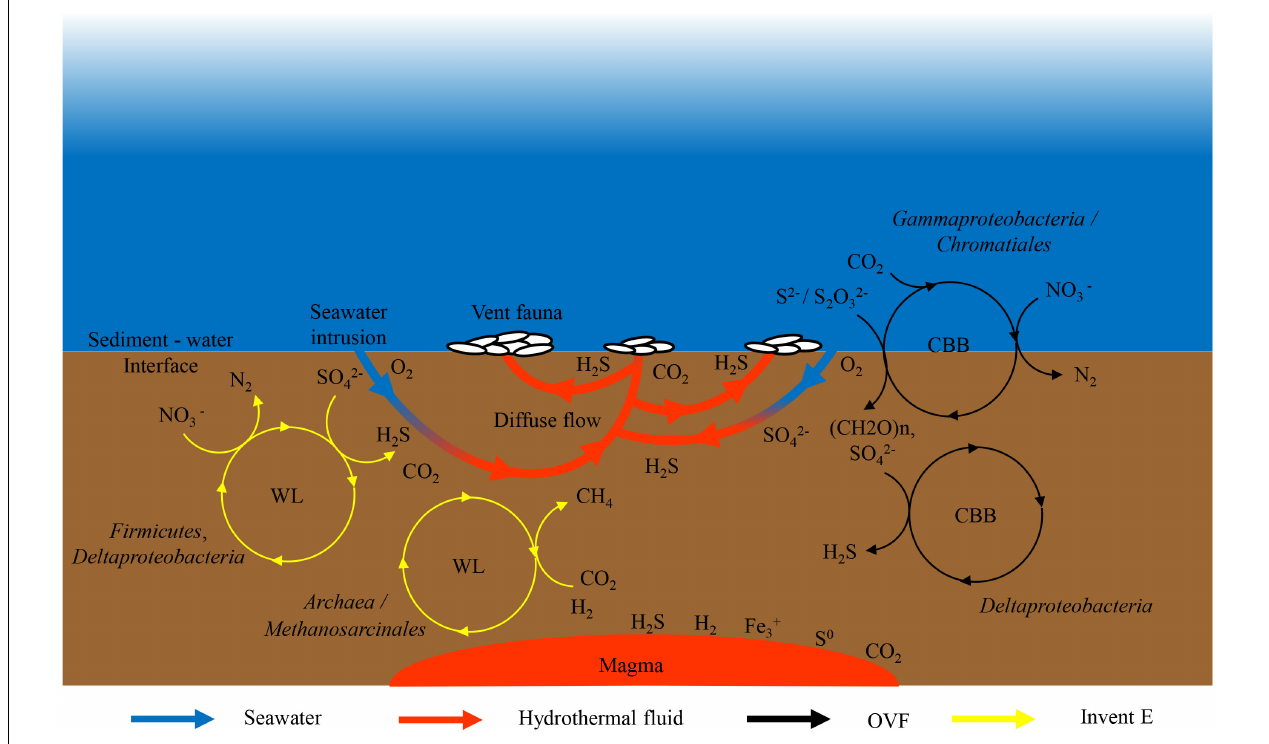
FIGURE 5 | Schematic illustration of key microbial metabolisms of carbon, sulfur, methane, and nitrogen in the diffuse flow hydrothermal vents at OVF and Invent E sites. SO 42 - , sulfate; S 0 , sulfur; S 2 O 32 - , thiosulfate; S 2 - , sulfide; H 2 S, hydrogen sulfide; NO 3 - , nitrate; N 2 , nitrogen; H 2 , hydrogen; CH 4 , methane; CO 2 , carbon dioxide; O 2 ,